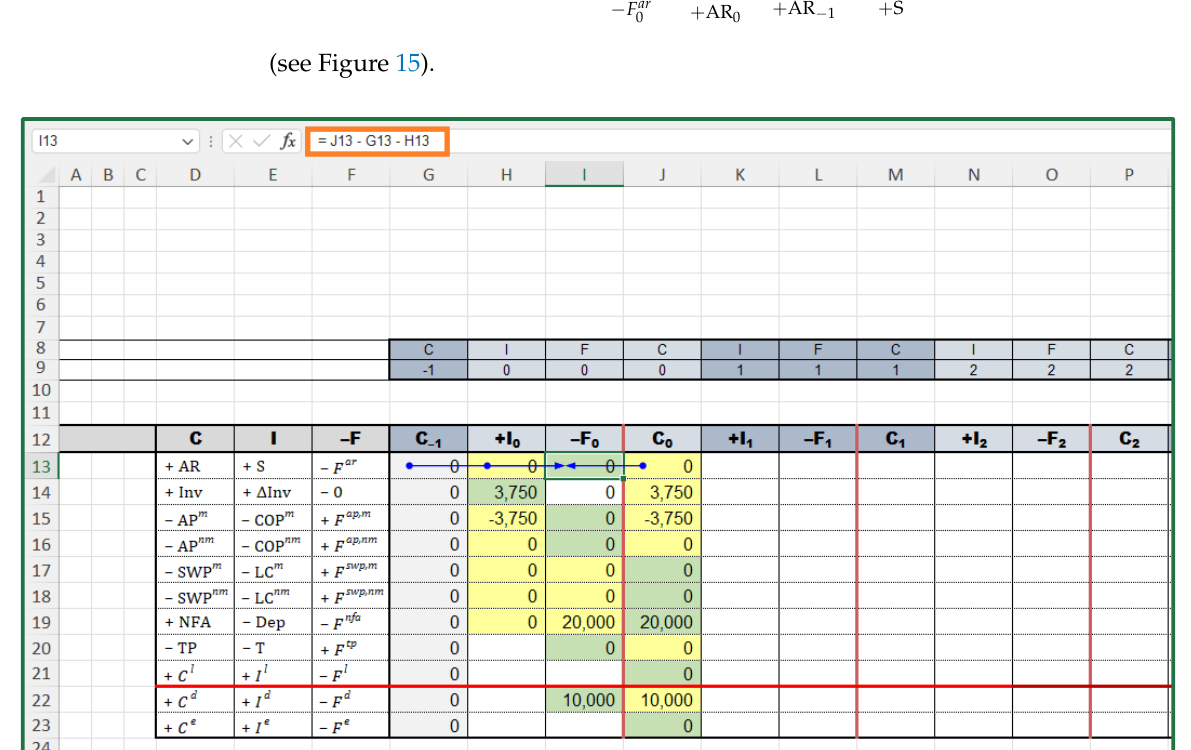
Figure 14. Cell H14 contains the law of motion for ΔInv (cid:2868) (“SplitScreenStrip” sheet). (The cells whose values are provided in “PreCalc” are in yellow and the cells whose values are calculated with the law of motion are in green.)